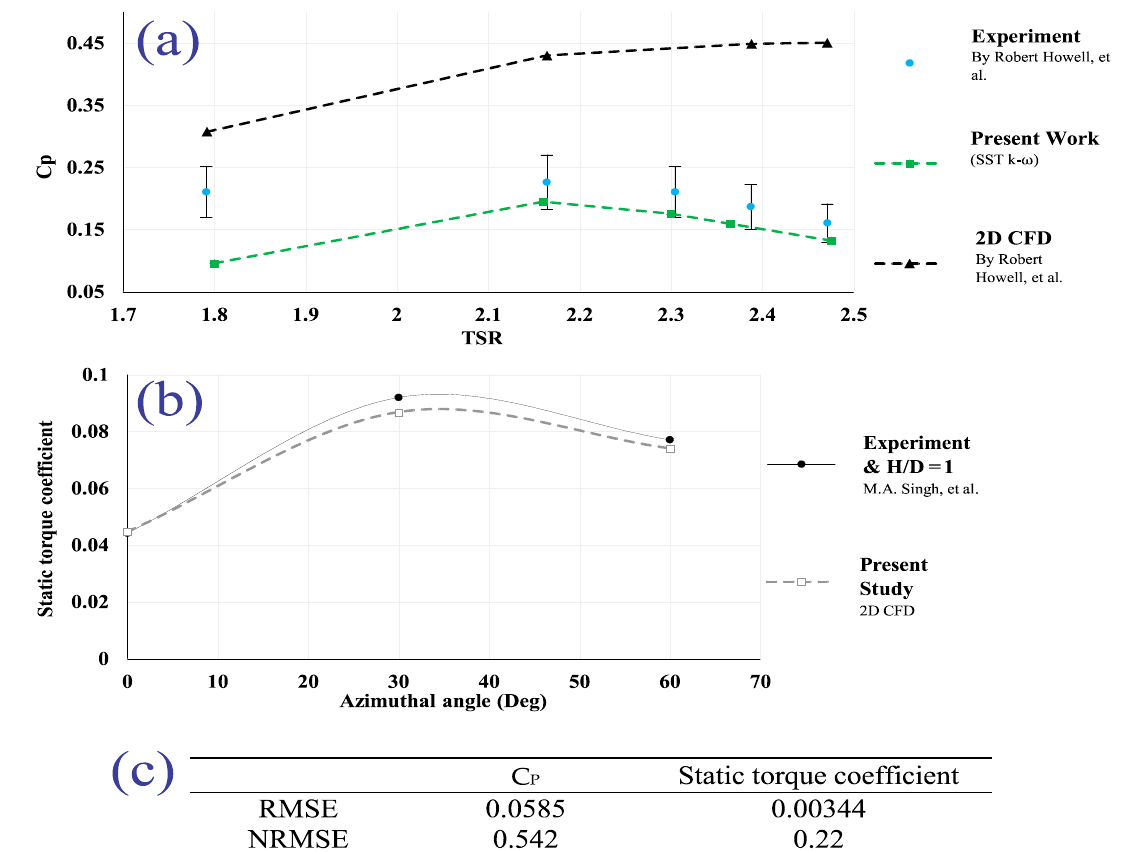
Figure 5. Validation: ( a ) dynamic simulation; ( b ) static simulation; ( c ) error analysis.